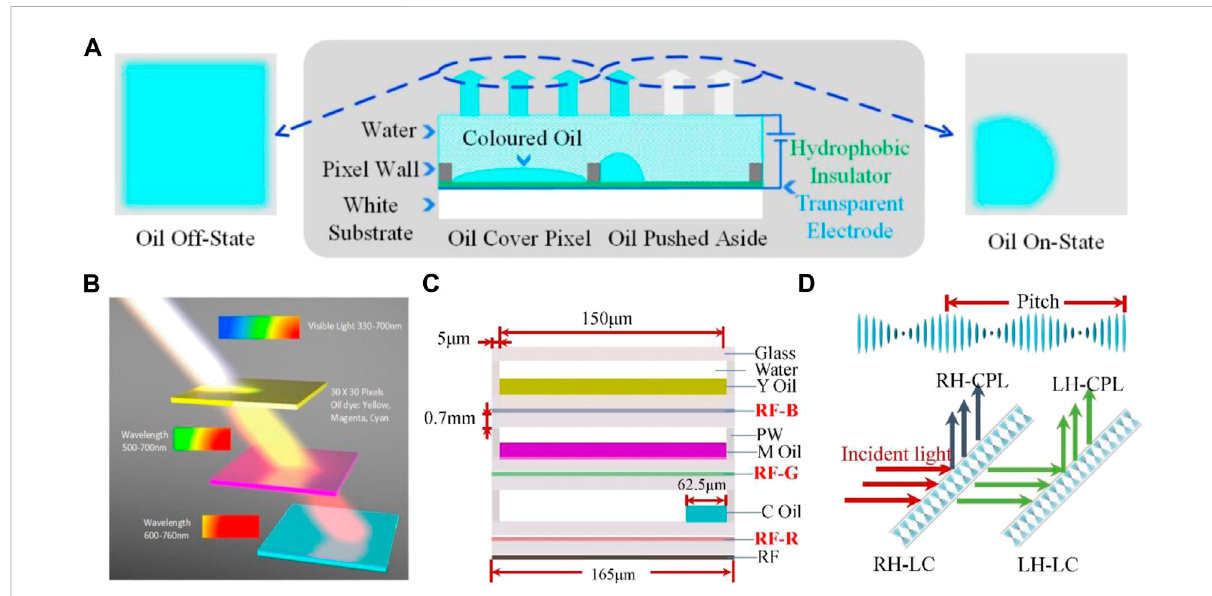
FIGURE 1 Schematic diagram of EWD device: (A) the working principle of EWD technology, (B) the vertical subtractive color mixing mechanism, (C) the basic structure and geometry parameters of tri-layers EWD pixels (here, PW: pixel wall, RF: re fl ector fi lm), (D) selective re fl ection principle of PCLC fi